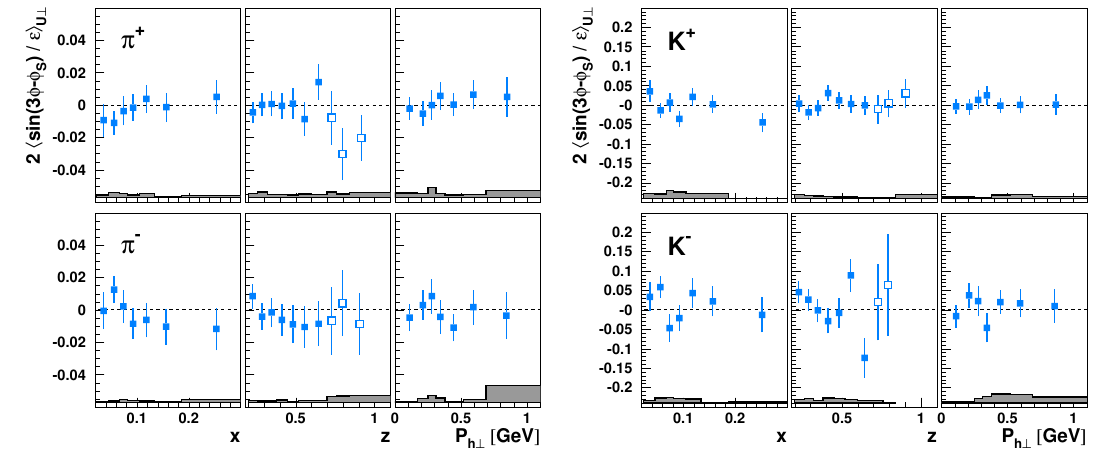
Figure 19 . Pretzelosity SFA for charged mesons (left: pions; right: kaons) presented either in bins of x , z , or P h ⊥ . Data at large values of z , marked by open points in the z projection, are not included in the other projections. Systematic uncertainties are given as bands, not including the additional scale uncertainty of 7.3% due to the precision of the target-polarization determination.